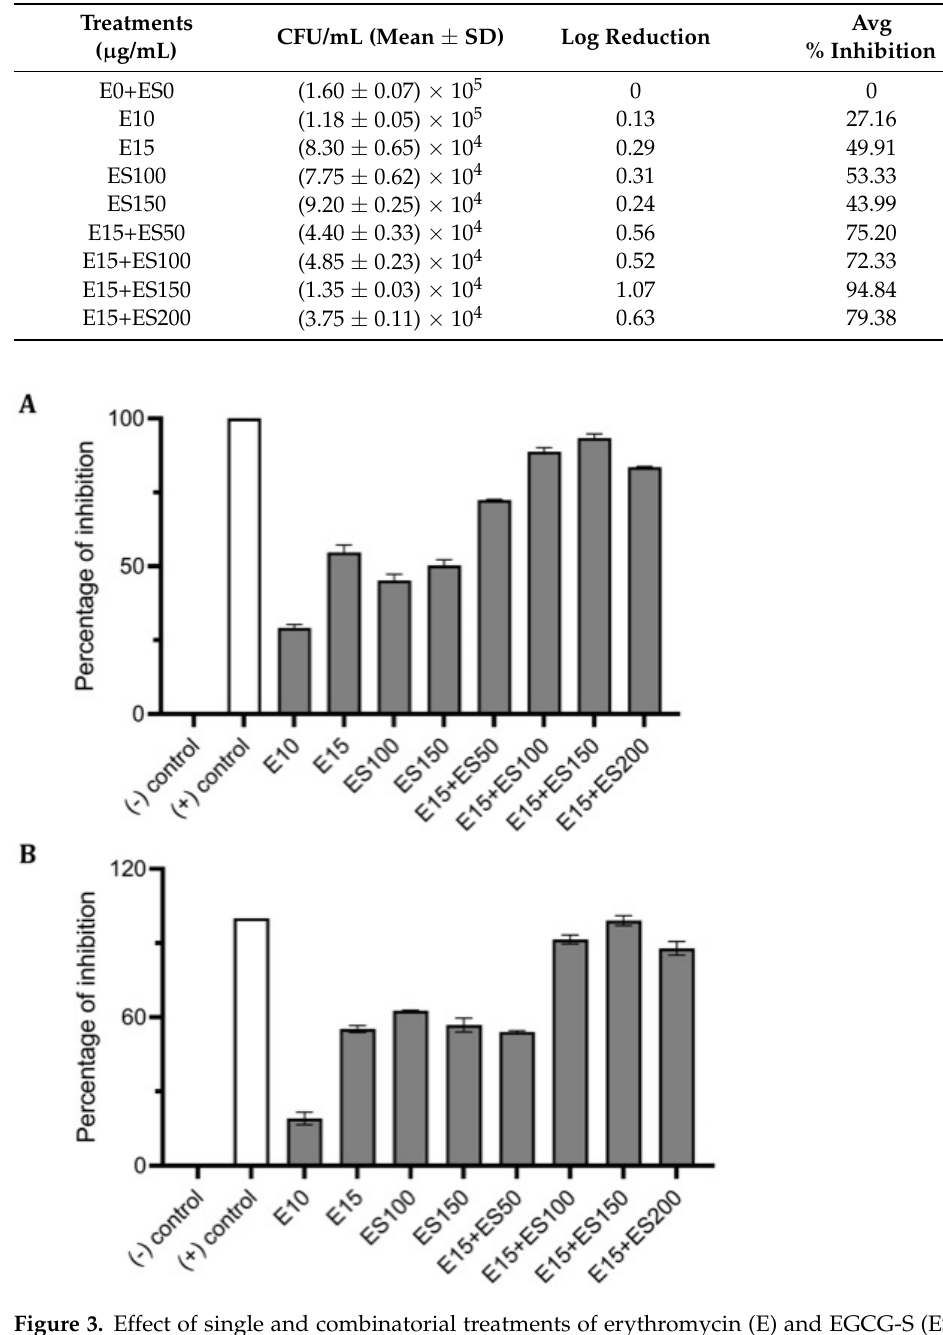
Figure 3. Effect of single and combinatorial treatments of erythromycin (E) and EGCG-S (ES) on biofilm formation in M. smegmatis . The percentage of inhibition for ( A ) crystal violet assay and ( B ) Resazurin assay were calculated from respective measurement. (-) control: PBS buffer; (+) control: 10% bleach. Experiments were repeated in triplicates. Means are shown with SD. The percentage of inhibition with different concentrations of erythromycin and EGCG-S indicated that E10+ES150 inhibits M. smegmatis biofilm formation most